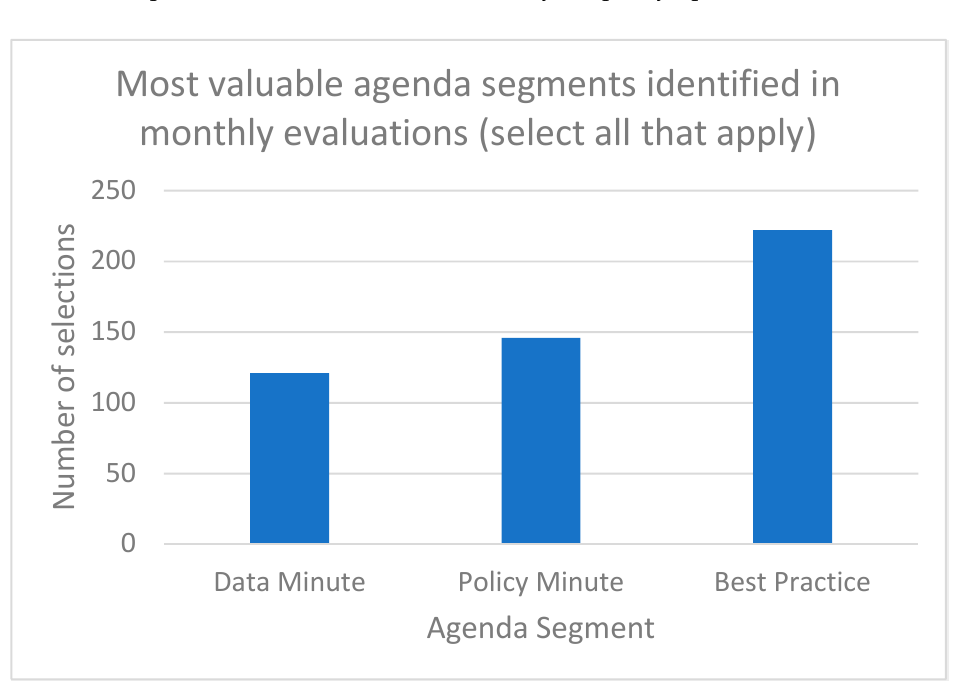
Figure 7. Most valuable huddle agenda segments identified in monthly participant surveys ( n =